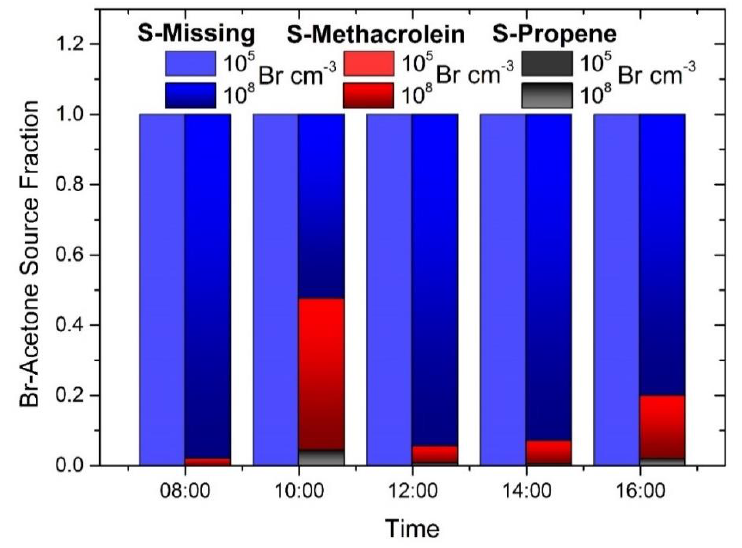
Figure 6. Source fractions contributing to the bromoacetone formation at 10 5 Br atoms cm −3 (left bright bars) and 10 8 Br atoms cm −3 (right darker bars) for Lake Boats. The Cl concentration was fixed at 10 4 cm −3 .